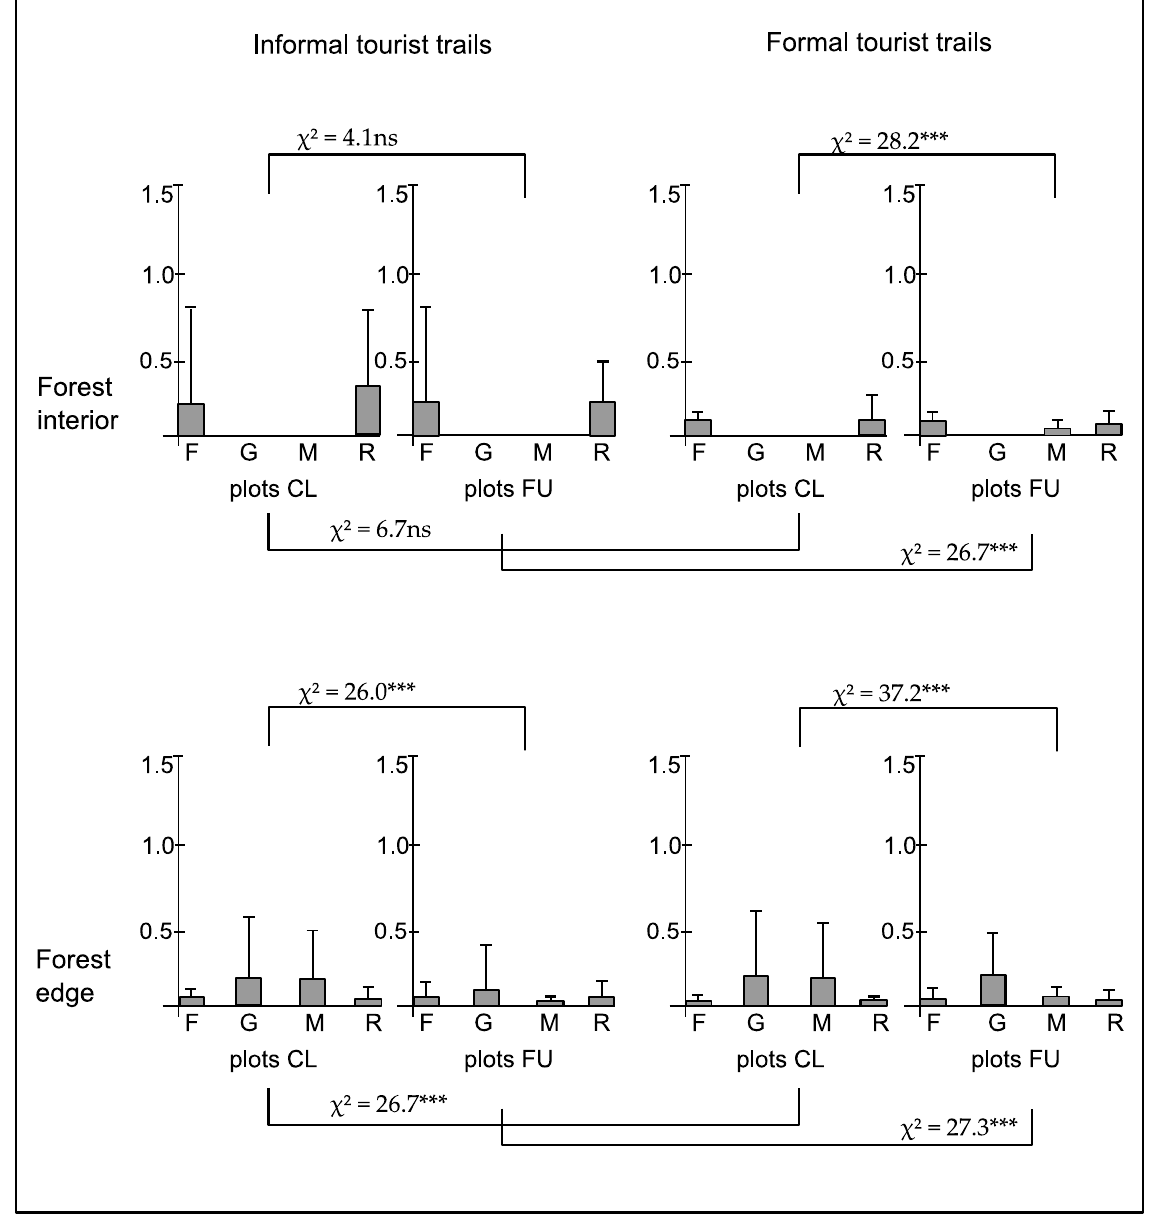
Figure 11. The mean cover-abundance degree of species (±SD) affiliated with forest (F), grassland (G), meadow (M) and ruderal (R) habitats per plot in closer (CL) and further (FU) plots located along informal (width < 50 cm) and formal (width > 150 cm) tourist trails within the forest interior and forest edge sites. The statistical significance level is explained in Figure 2.